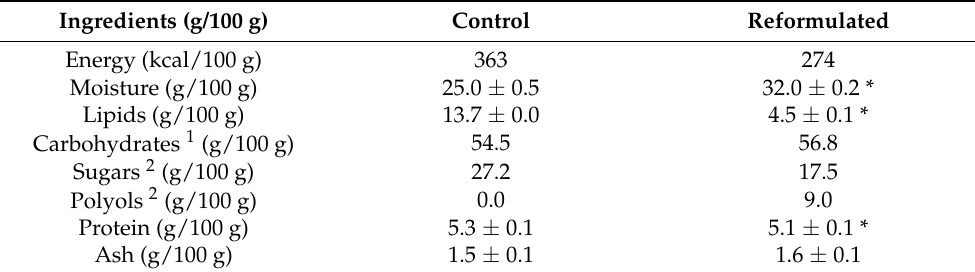
Table 2. Nutritional composition of control and reformulated cakes. Ingredients (g/100 g) Control Reformulated Energy (kcal/100 g) 363